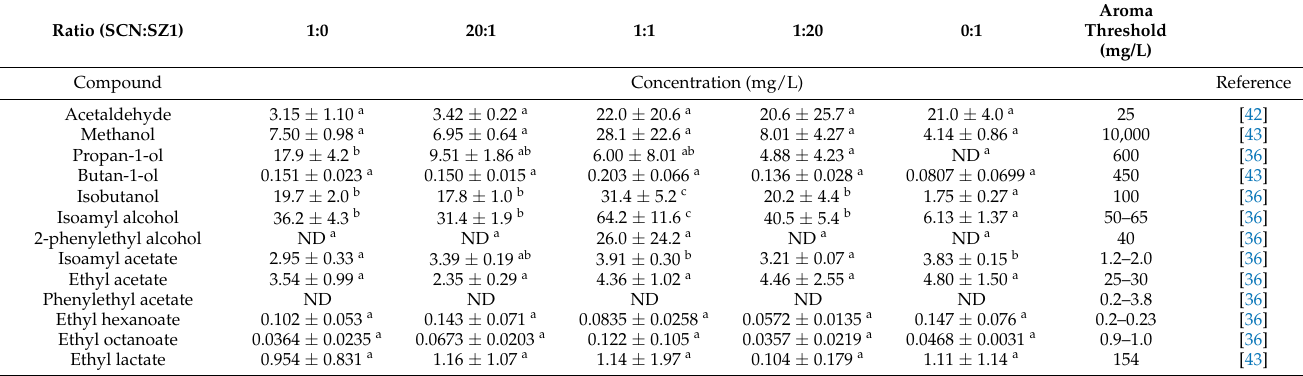
Table 3. Volatile organic compounds in fermented wort inoculated with S. cerevisiae (SCN) and S. pombe (SZ1) monocultures, and three mixed cultures at 20:1, 1:1, and 1:20 initial inoculation ratio in standard-gravity wort